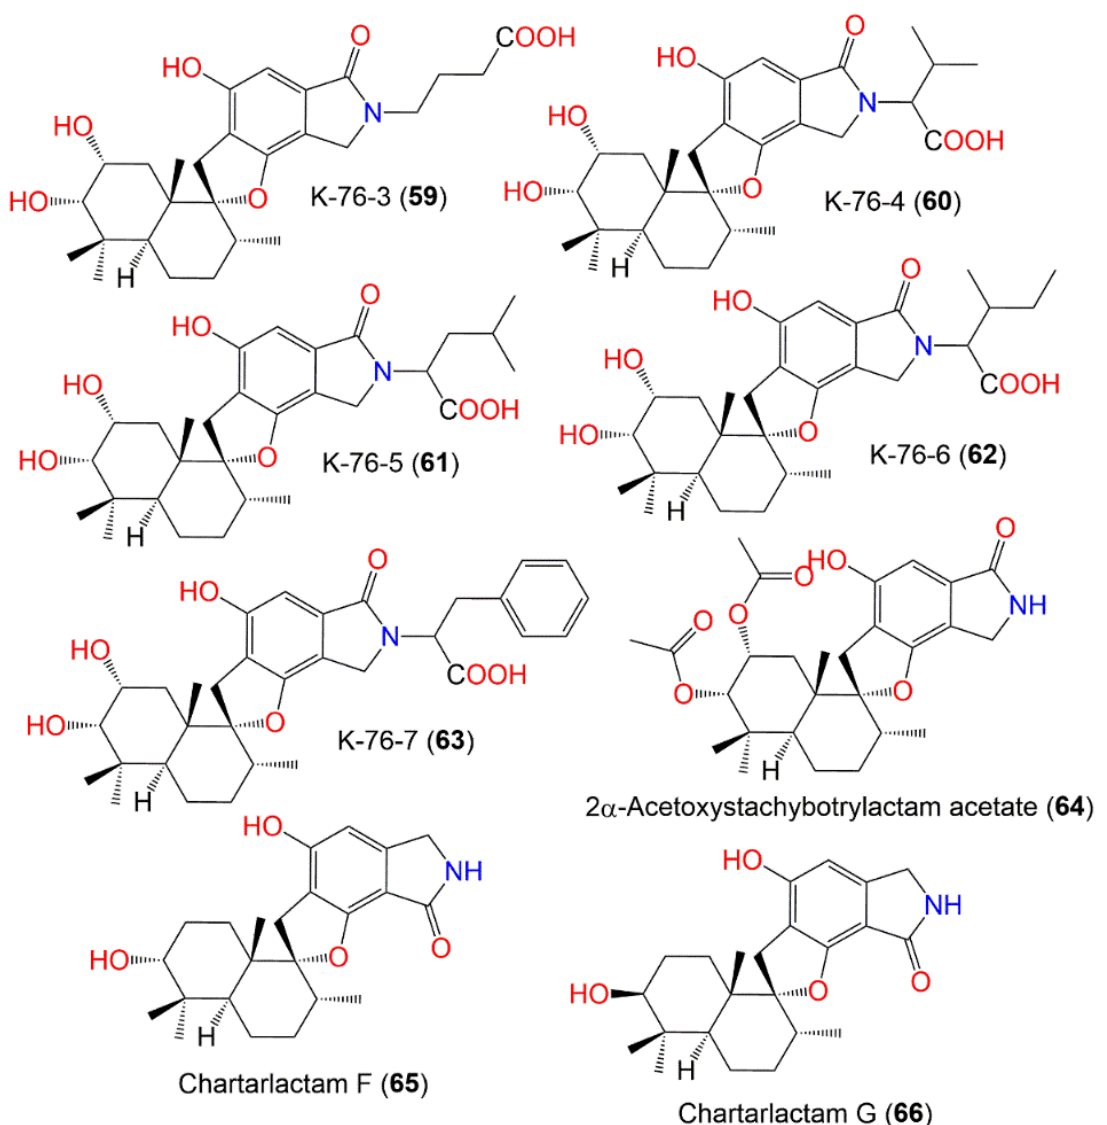
Figure 6. Structures of phenylspirodrimane derivatives ( 59 – 66 ) reported from S . chartarum . Zhao et al. reported the separation of three dimers: bistachybotrysins A–C ( 73 – 75 ) from S. chartarum CGMCC-3.5365 mycelia EtOAc extract by SiO 2 CC and HPLC that were assigned based on spectroscopic and ECD analyses. These metabolites are phenylspirodri- mane dimers having [6,6,7,6]-tetracyclic scaffold with 6/7 oxygen heterocycle linkage and a central 2,10-dioxabicyclo[4.3.1]decan-7-ol core fused with two phenyl moieties (Figure